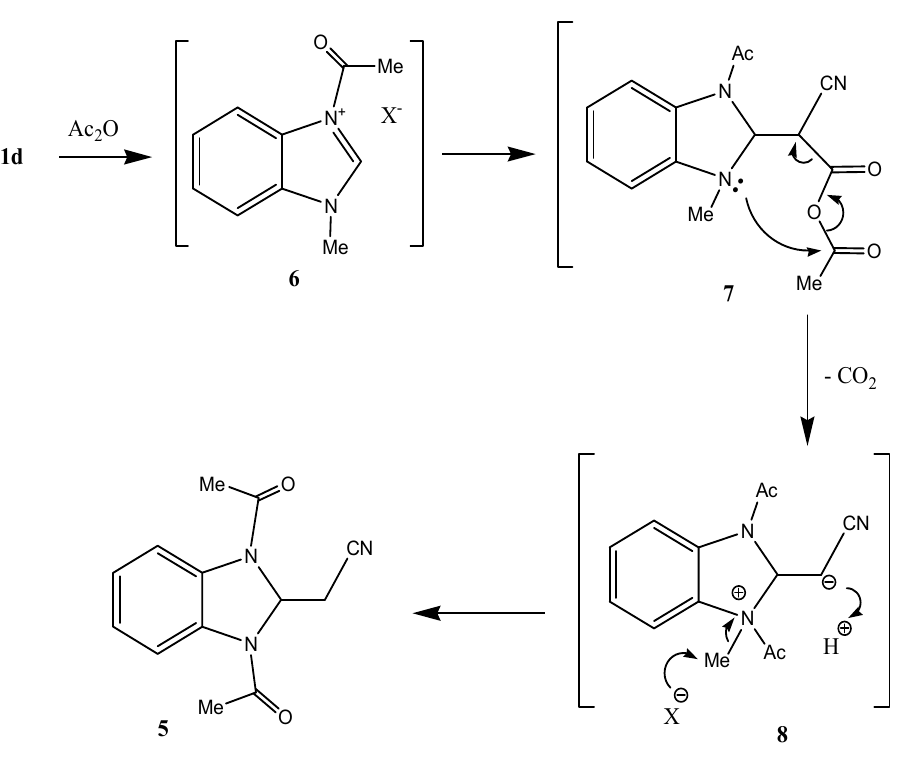
Scheme 2. Suggested mechanism for formation of 5